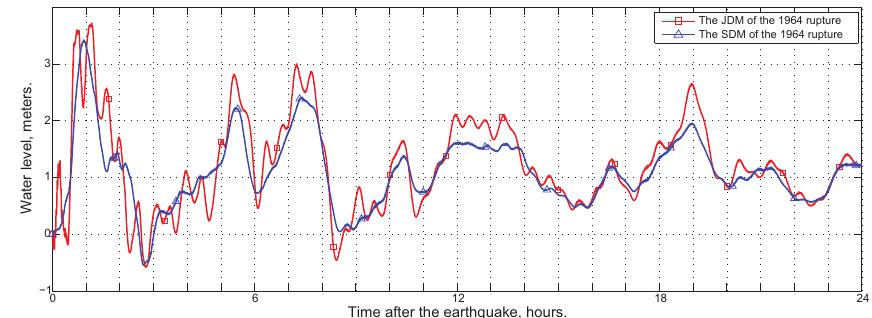
Fig. 12. Modeled water level dynamics at Point 2 (Fig. 2) in the Whittier harbor during the 1964 tectonic tsunami, based on the SDM and JDM. A change in the sea level due to tides is not modeled. Elevation in meters with respect to the post-earthquake MLLW datum.